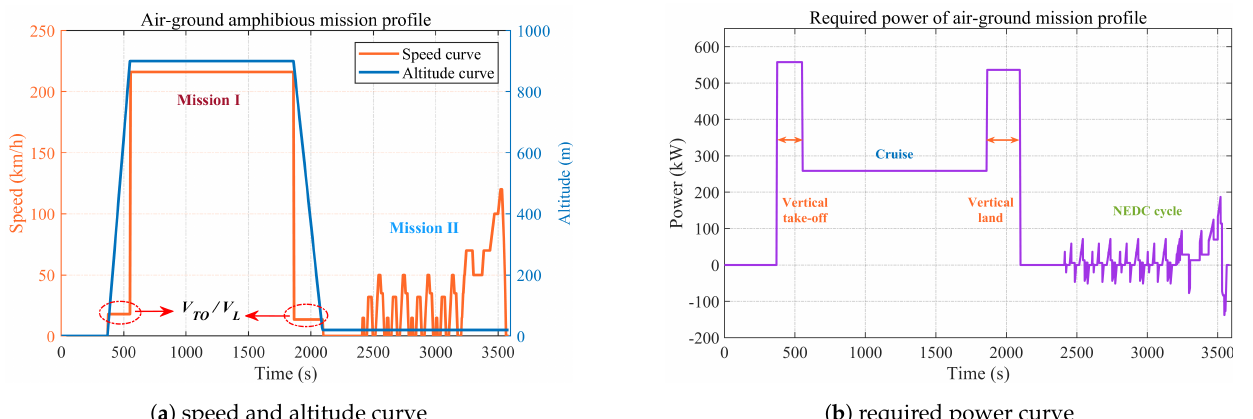
Figure 12. Speed, altitude, and required power curve of HAGA in the air–ground amphibious